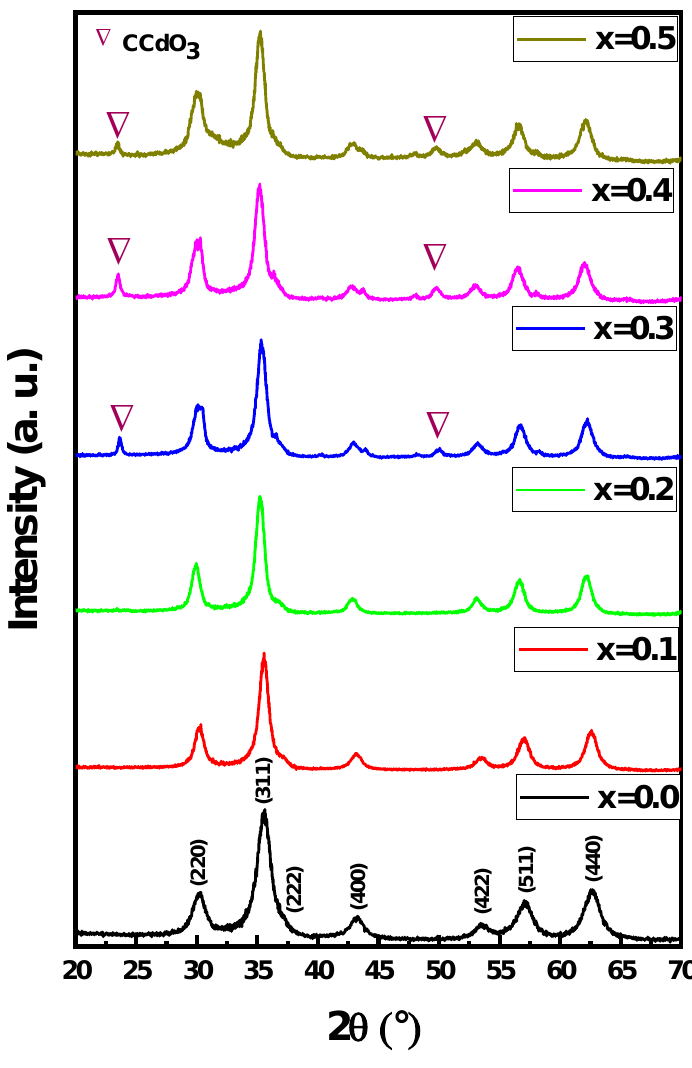
Figure 1. XRD powder patterns of (Mn 0.5 Zn 0.5 )[Cd x Fe 2 − x ]O 4 (x ≤ 0.05) NSFs.